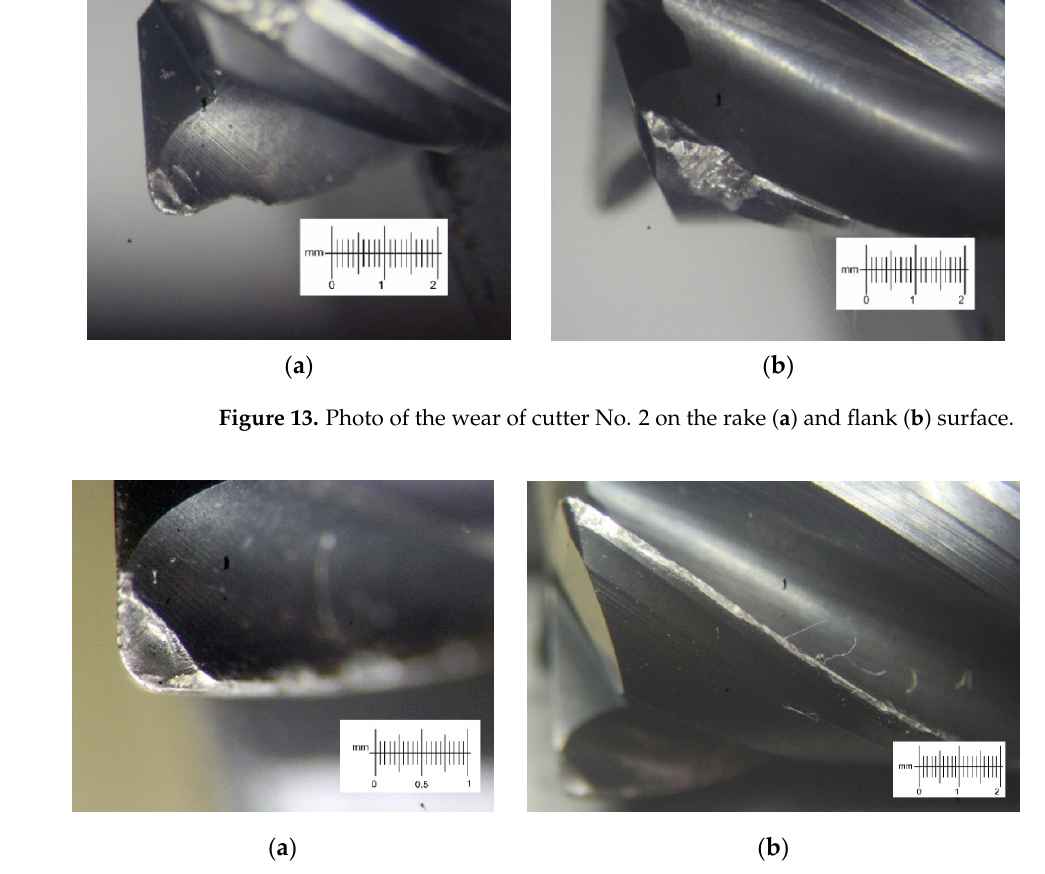
Figure 15. Point force application diagram for different of milling depth to width ratios.